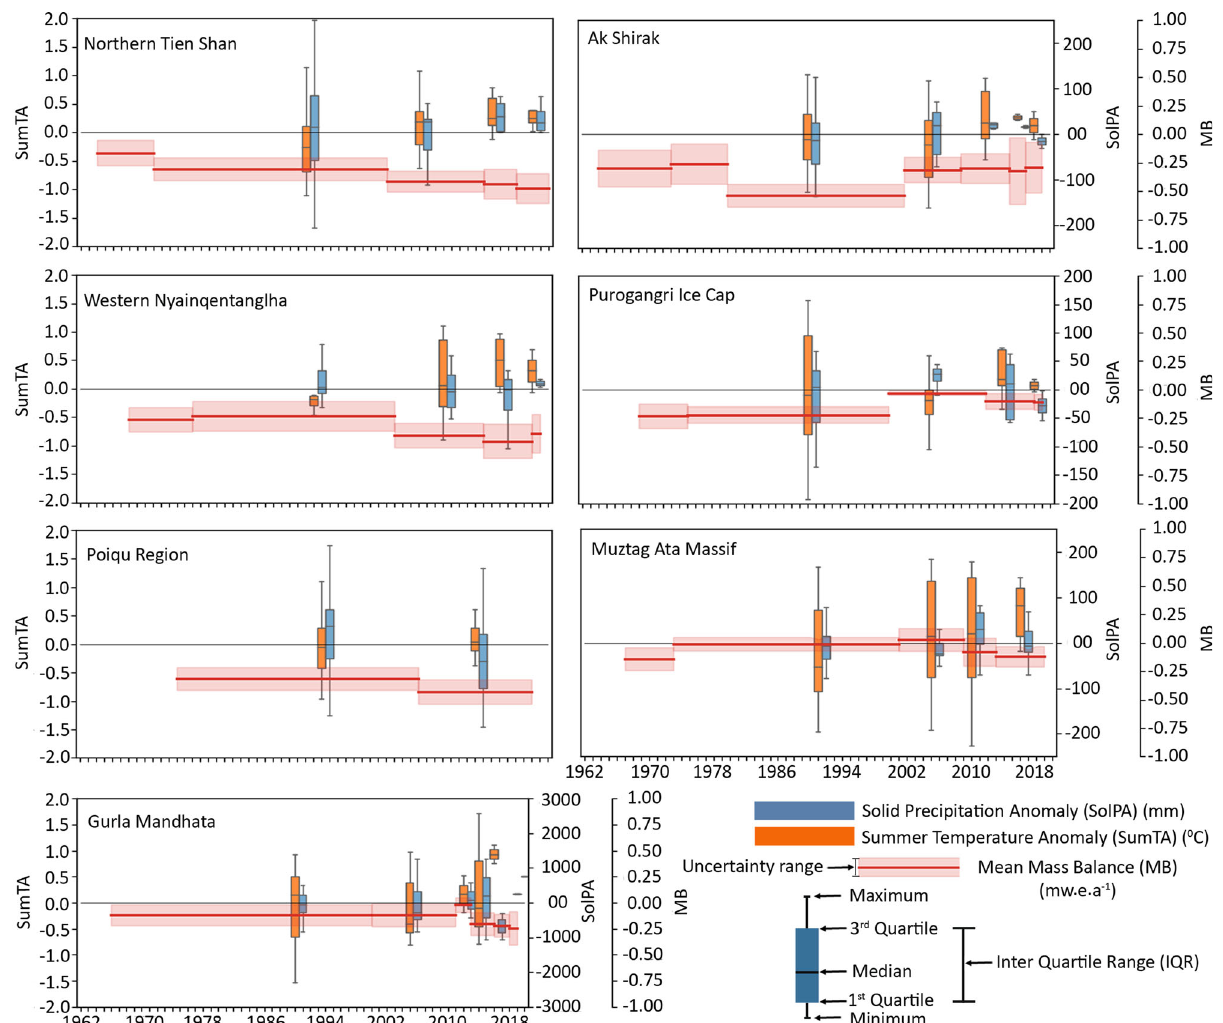
Fig. 4 Comparison of average annual mass change rate of glaciers with ERA5 Land climate variables for all study regions in different time periods. Summer temperature and solid precipitation anomalies of ERA5 Land gridded climate data (available since 1981) along with geodetic glacier mass balance estimates for the different regions (left column: more humid regions; right column: drier regions) and each time